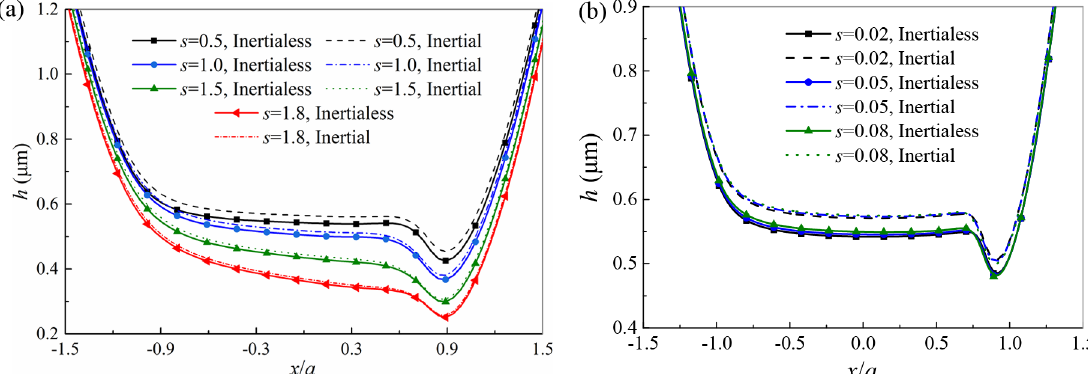
Fig. 14. Effects of inertia on fi lm thickness at varied slide-roll ratio ( y =0): (a) for large slide-roll ratio, and (b) for small slide-roll ratio.